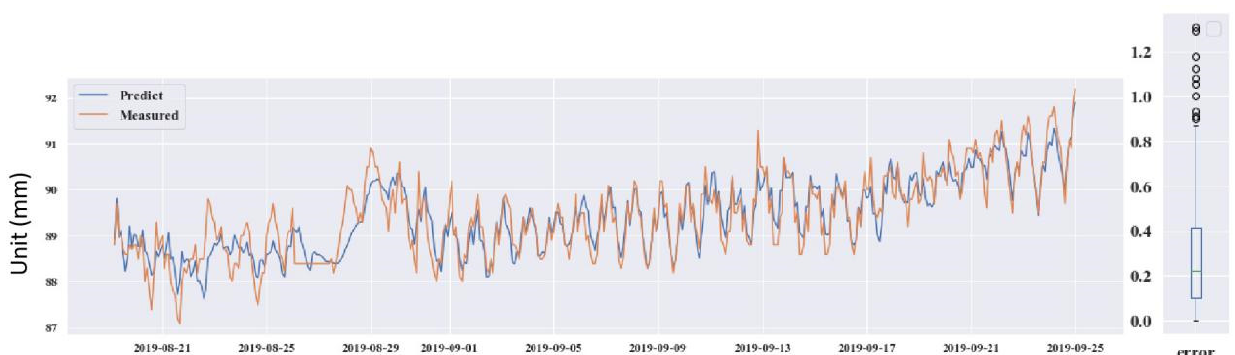
Figure 13. Predicted and measured planar displacement of GPS 04.